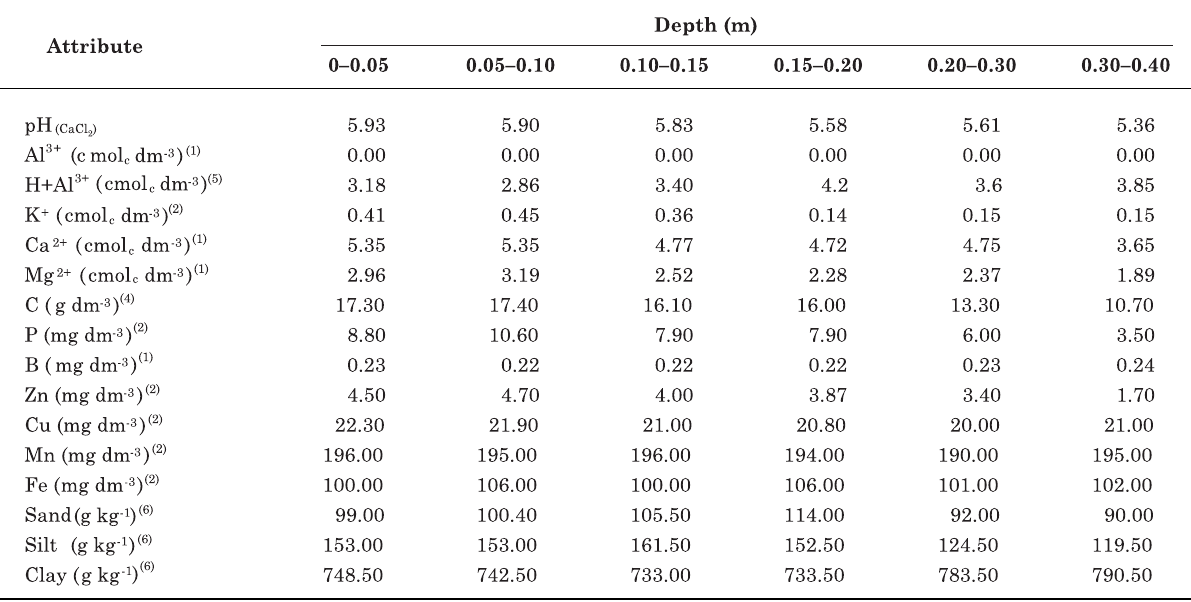
Table 1. Chemical and physical characteristics of soil collected from different depths prior to boron